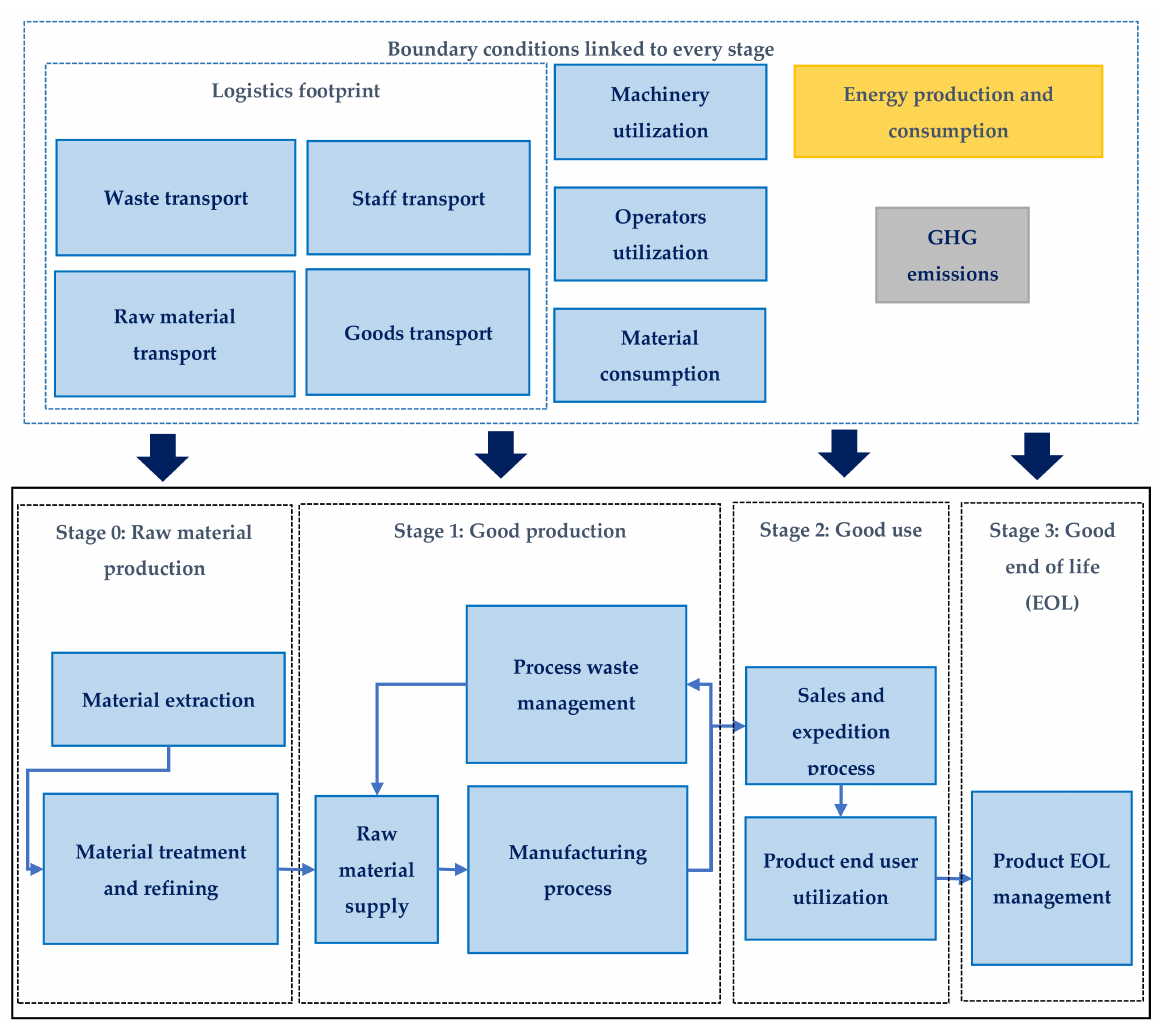
Figure 1. LCA flow diagram. Table 2. Main scenarios that compose the LCI and subsequent